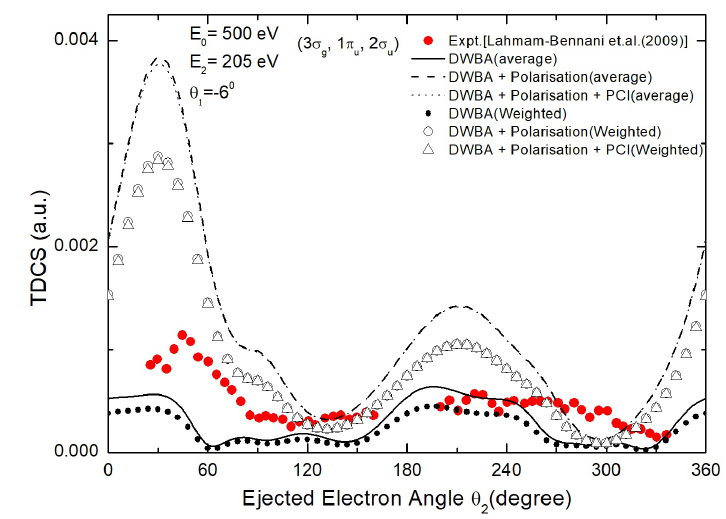
Figure 3. Same as Figure 1. The ejected electron energy is 205